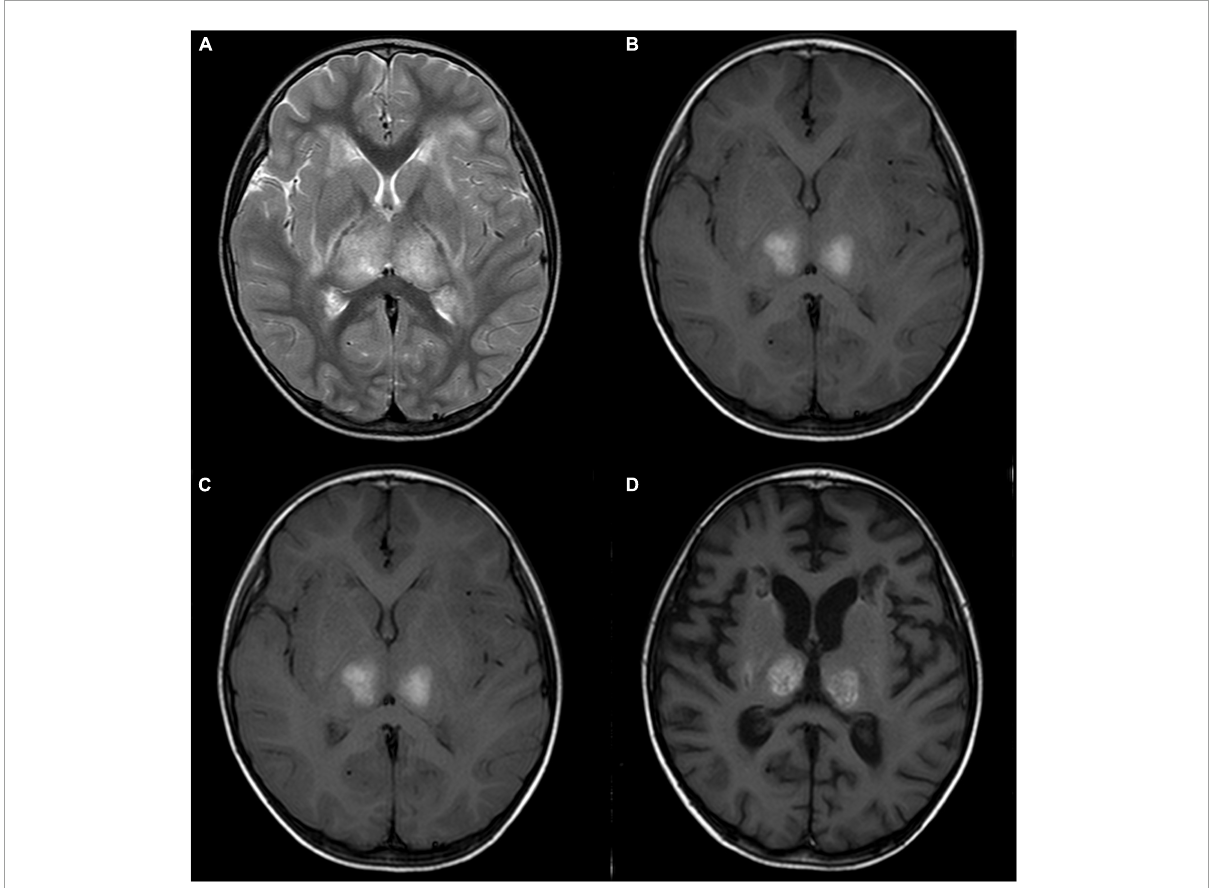
FIGURE2 A 2-year-old girl with acute necrotizing encephalopathy, with fever and seizure. (A) T2WI shows slightly high symmetrical signals in the bilateral thalamus. (B) T1WI shows symmetrical hyperintensity in the bilateral thalamus. (C) One month later, T2WI shows irregular high signal in bilateral thalamus. (D) One month later, T1WI shows irregular high signal in bilateral